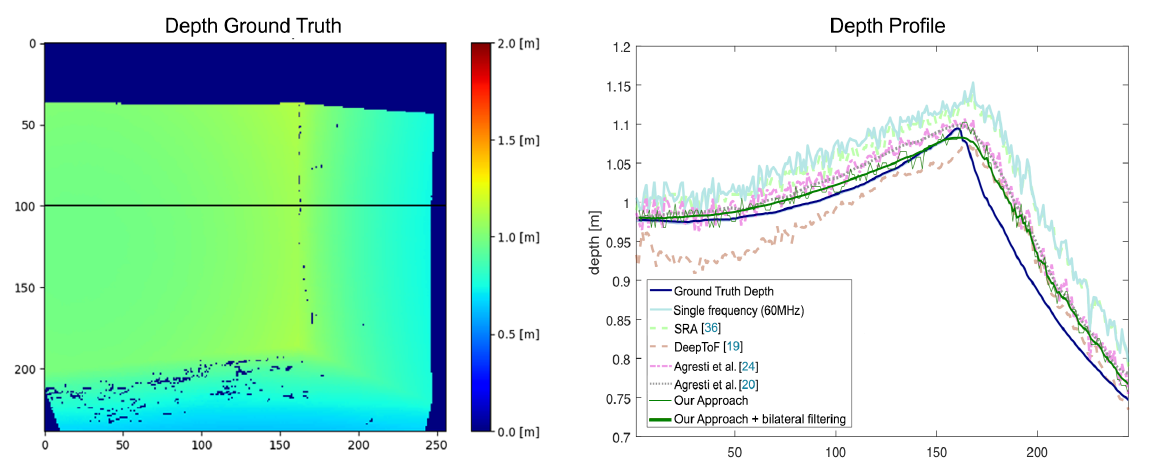
Figure 8. Depth profile estimation in proximity of a corner. The left plot reports the depth ground map, while the right one compares with our approach the depth profile over the highlighted line on the left image, estimated by different state-of-the-art MPI correction